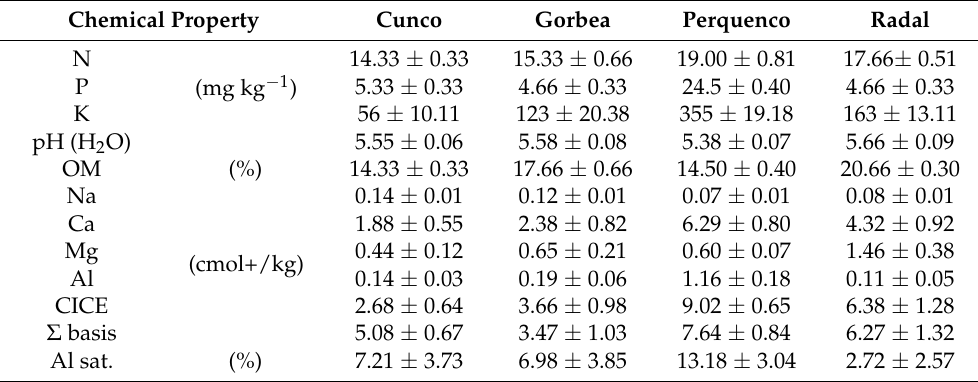
Table 5. Chemical parameters in soil samples (0 to 30 cm in depth) from the four studied localities (Cunco, Gorbea, Perquenco, and Radal) were evaluated prior to spray treatment in September 2018. Values represent the mean ( n =